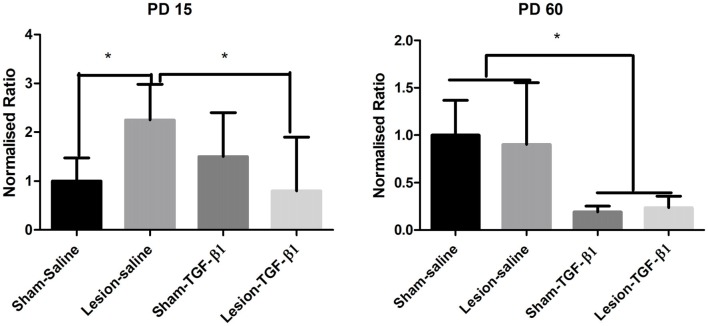
Levels of expression of IL-1β from sham and NVHL animals from medial PFC at PD15 and PD60 following neonatal TGF-β1 administration. Quantification of Q-RTPCR data (normalized ratio of IL-1β gene over housekeeping gene) expression at two developmental time points PD15 and PD60. A two-way ANOVA revealed a significant lesion × TGF-B1 interaction from PD15 group of animals (*p = 0.007). Post hoc test showed that IL-1β expression was significantly increased in the lesion-saline group as compared to sham-saline group (*p = 0.0169) at PD15. A significant reduction of IL-1β was observed in the lesion-TGF-β1 group as compared to lesion-saline group (*p = 0.0244). From PD60 group of animals only a significant main effect of TGF-β1 treatment was observed on IL-1β expression (*p = 0.001) (n = 4–8 per group).